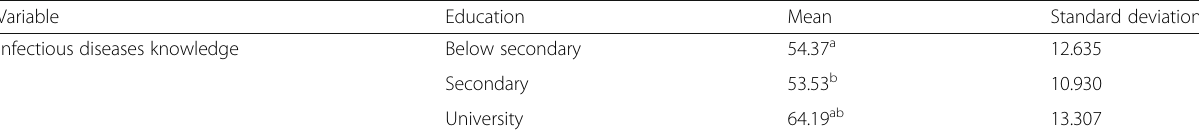
Table 3 Post hoc test using Tukey HSD for multiple comparisons of education as a factor affecting infectious disease knowledge among caregivers (Alexandria, 2015)